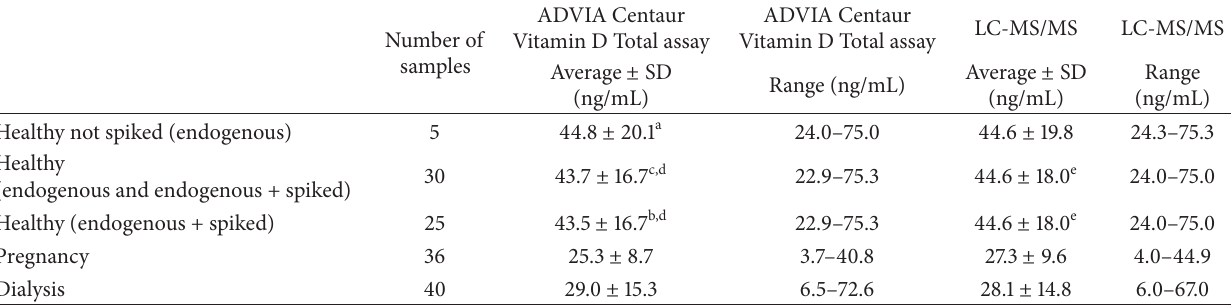
Table 2: Serum concentrations of 25(OH)D in healthy subjects, DBP-spiked samples from healthy subjects, pregnant women, and dialysis patients.